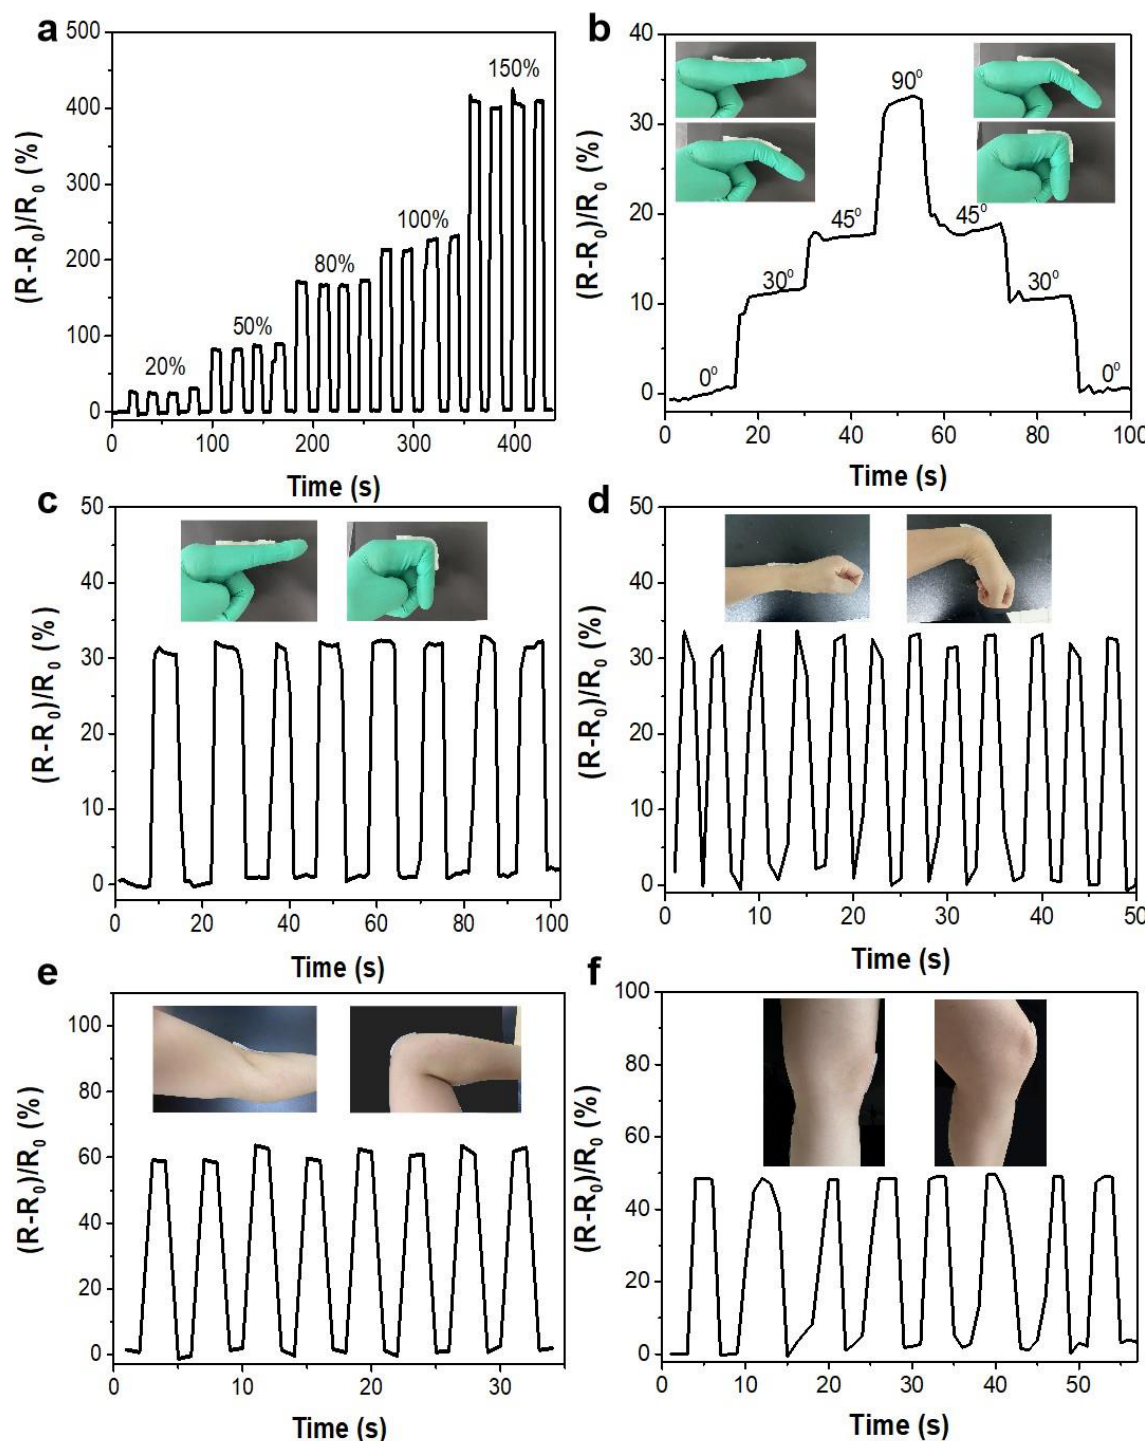
Figure 5. Relative resistance change vs. time for the gel-based strain sensor under various cyclic strains: ( a ) different elongations (20, 50, 80, 100, 150%); ( b ) different bending angles of the forefinger; with different joint movements of the human body: ( c ) forefinger, ( d ) wrist, ( e ) elbow, ( f ) knee.